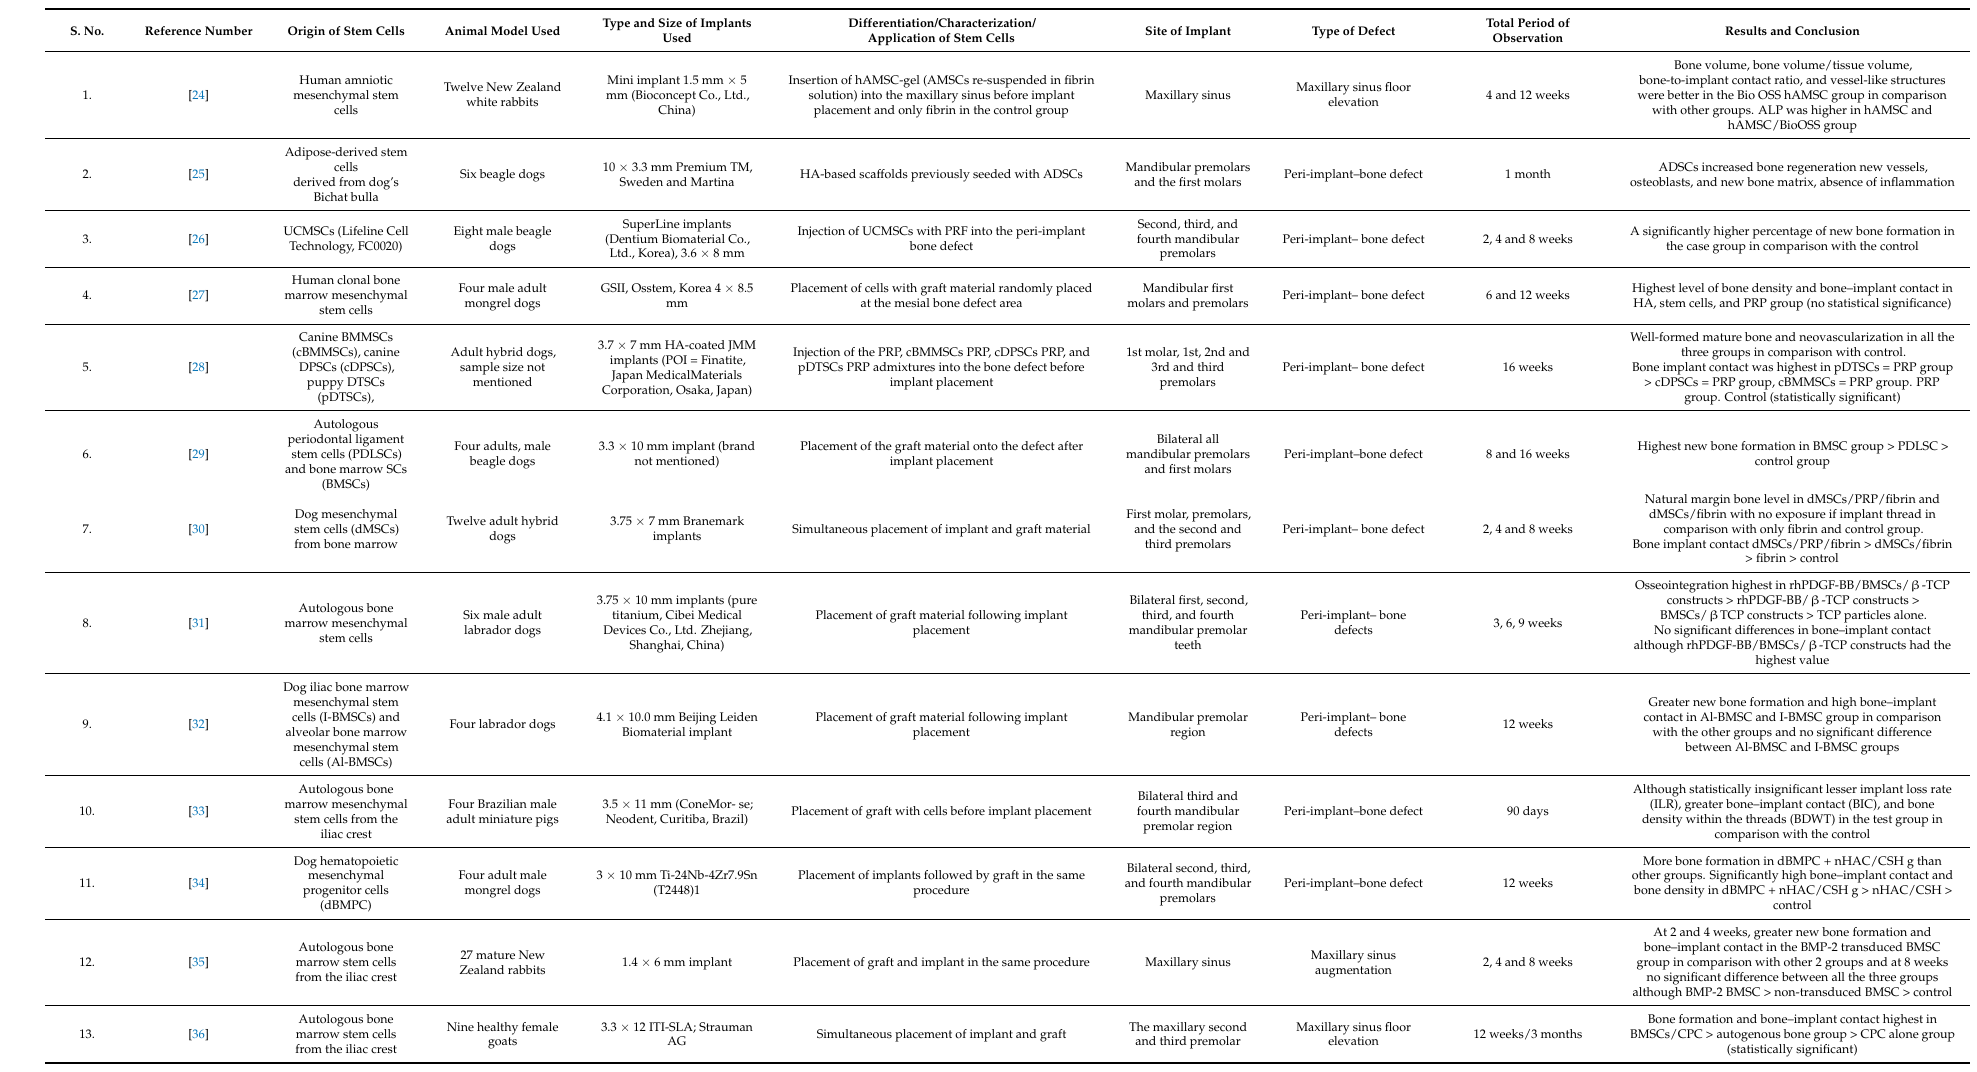
Table 1. Summary of the data extracted from the included